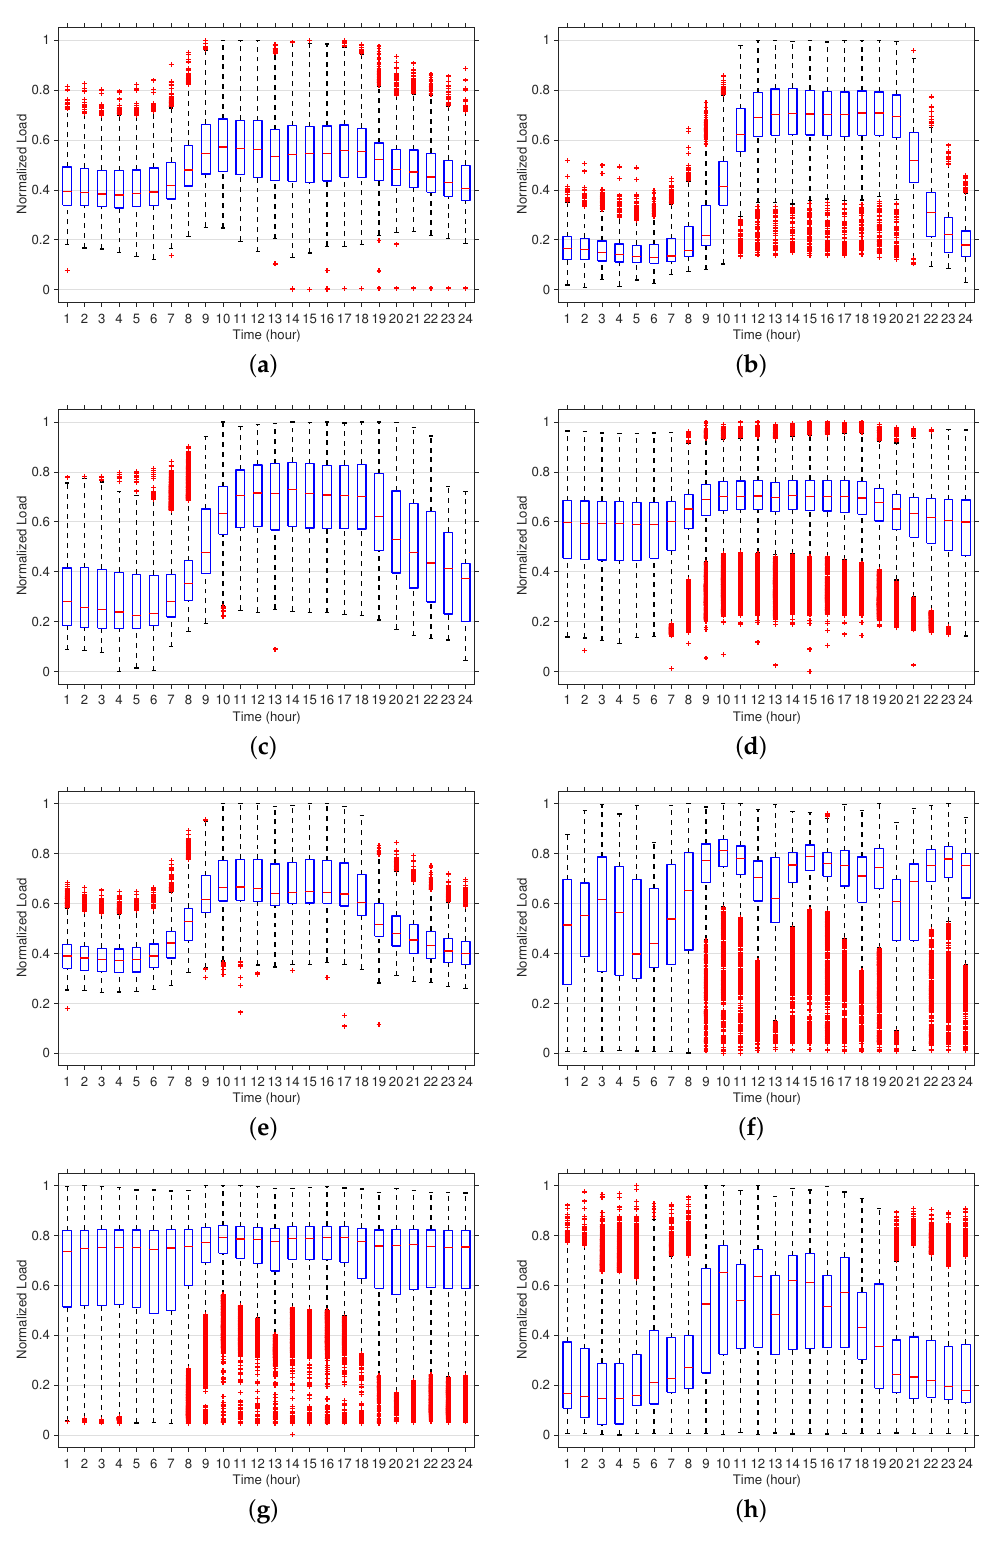
Figure 6. Box plot of normalized daily electricity consumptions: ( a ) Public administration; ( b ) Retail business; ( c ) R&D services; ( d ) Networking business; ( e ) Healthcare; ( f ) Vehicle and trailer manufacturing industry; ( g ) Electronic component and computer manufacturing industry; ( h ) Other manufacturing